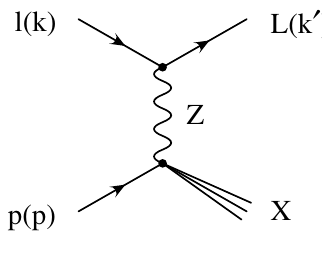
Figure 3 . Feynman diagram for heavy lepton production l + p ! L + X